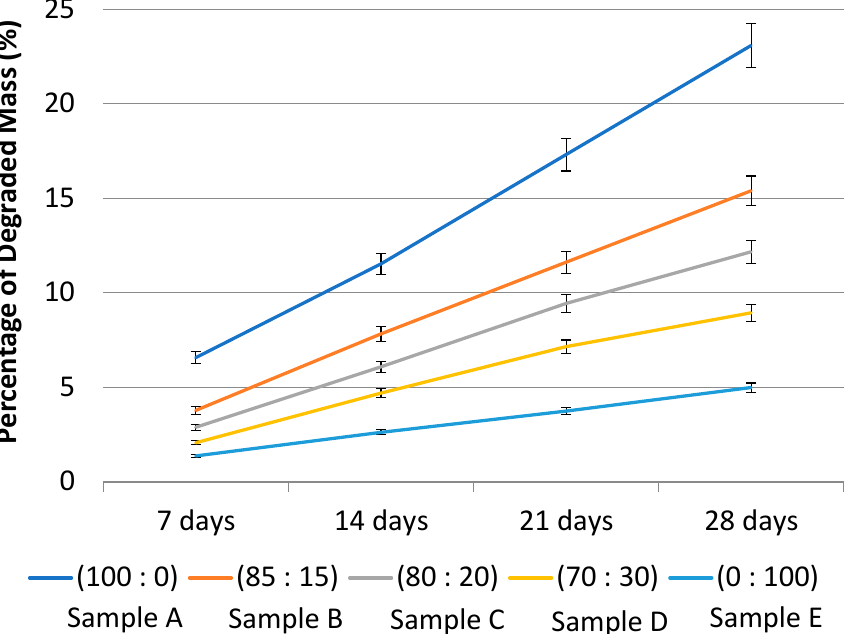
Figure 6. Graph of the average percentage of degraded mass of the samples with a composition of